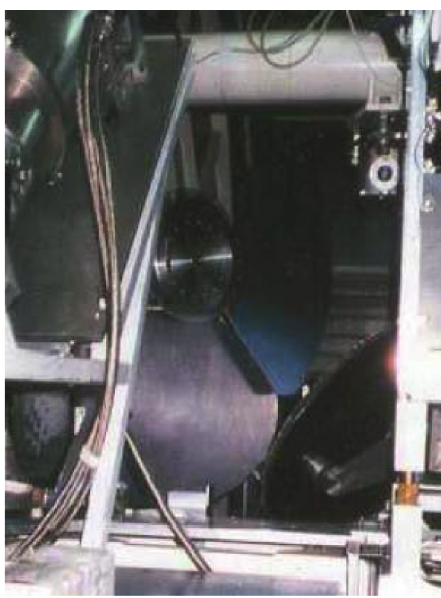
Figure 5: The chopper wheel calibration system of